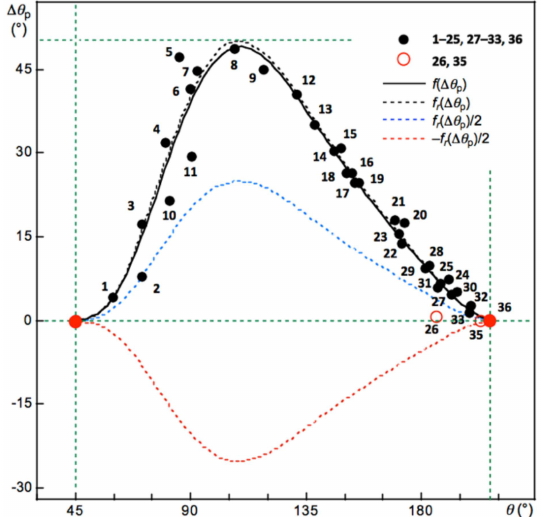
Figure 2. Plots of ∆ θ p versus θ for the standard interactions of 1 – 36 , evaluated with MP2/BSS-A. Numbers are the same as the numbers in Scheme 1. Red circles correspond to the θ period of 45.0 ◦ ≤ θ ≤ 206.6 ◦ and green horizontal lines are for ∆ θ p = 0 ◦ and 50.0 ◦